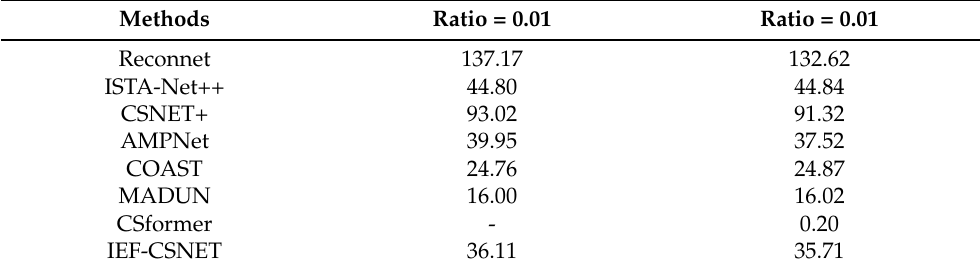
Table 3. The number of images that can be processed by different methods per second. The inference of 256 × 256 images is executed 105 times, and the average running time of the next 100 times is taken as the final result of the running time t of each image. All images are processed with B = 1. The number of pictures that can be processed per second is 1/ t